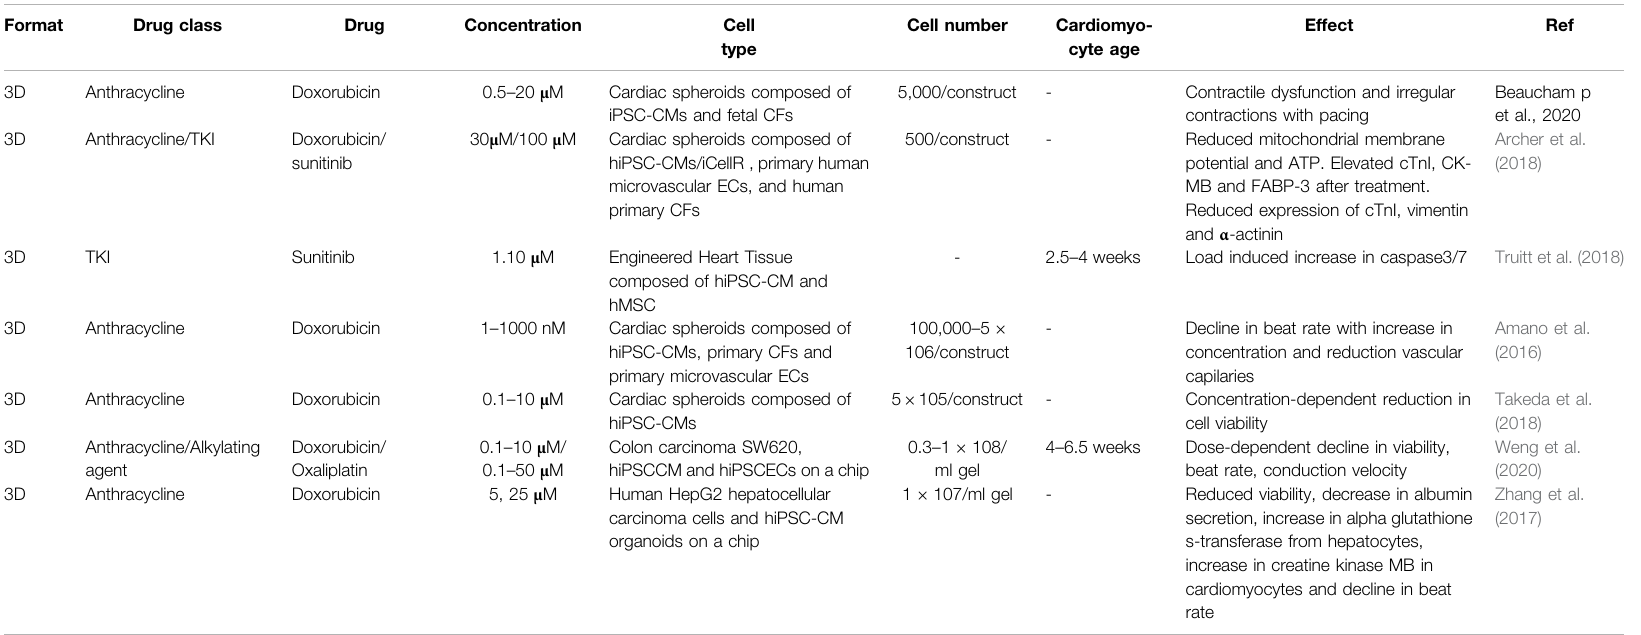
TABLE 1 | ( Continued ) A summary of in vitro stem cell-based cardiac models for cancer drug